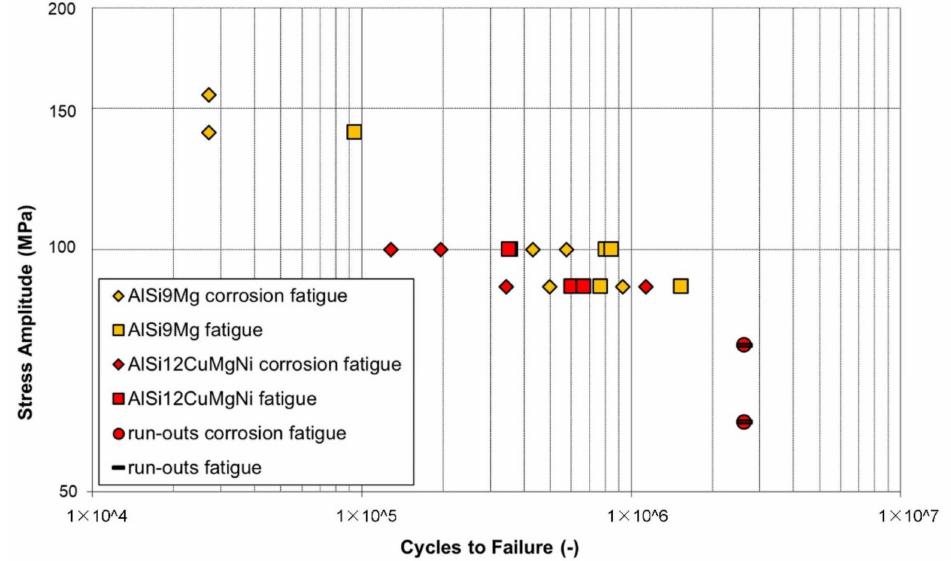
Figure 9. Fatigue and corrosion fatigue strength data of AlSi9Mg and AlSi12CuMgNi